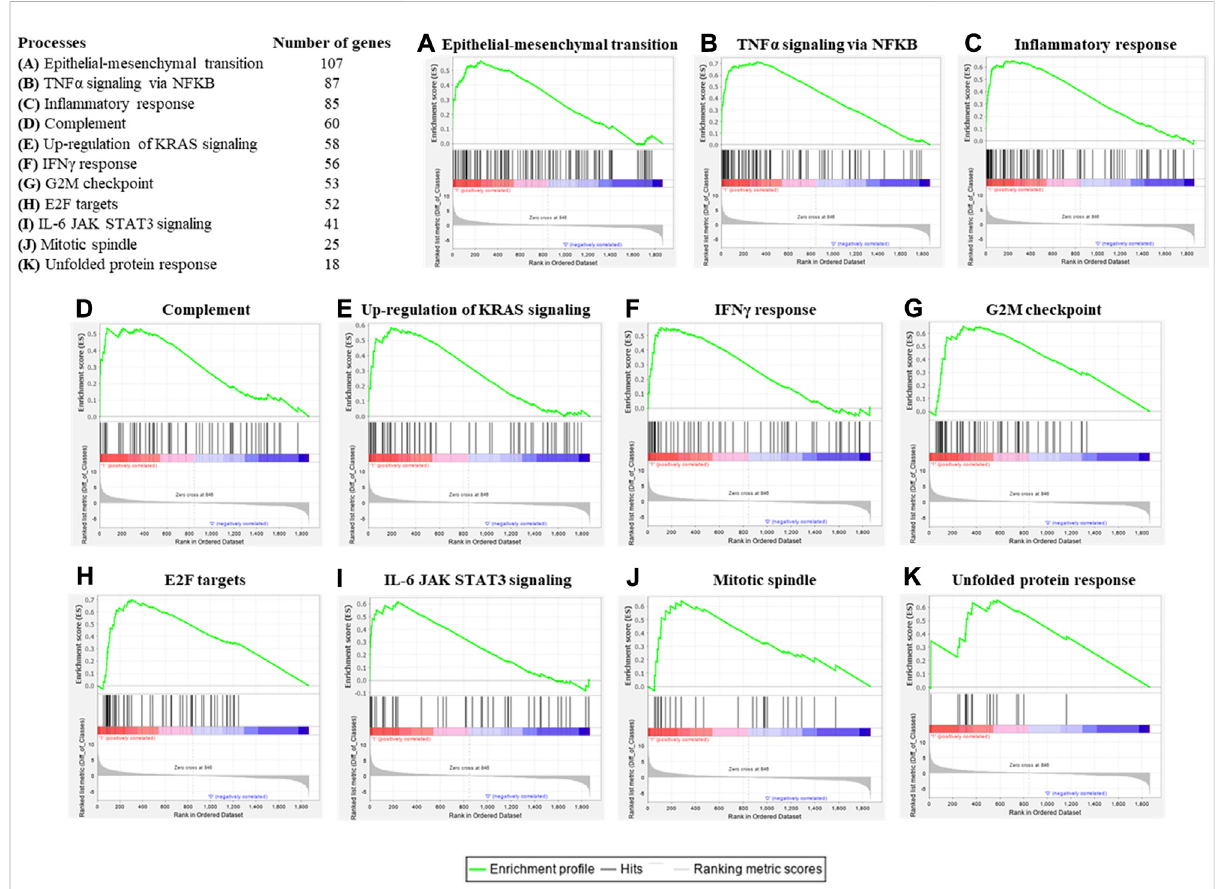
FIGURE 3 Enrichment plots of signi fi cant gene sets belonging to the (H) collection by GSEA. Table shows the hallmark processes identi fi ed by GSEA as signi fi cantlyenriched( p valueandqvalue < 0.05)andthenumberofgenesbelongingtoeachgenesetandthatwasdetectablealsointhegenearray. Enrichmentplotsforepithelial-mesenchymaltransition (A) ,TNF α signaling via NF-KB (B) ,in fl ammatoryresponse (C) ,complement (D) ,up-regulation of KRAS signaling (E) , IFN γ response (F) , G2M checkpoint (G) , E2F targets (H) , IL-6 JAK STAT3 signaling (I) , mitotic spindle (J) and unfolded protein response (K) were shown. An enrichment plot shows the gene set name (top), the running enrichment score (green curve), the positions of the gene set hits on the rank ordered list in GSEA (black bars), and the rank ordered list according to the signal-to-noise metric (bottom). Red indicates the up-regulation, whereas blue indicates the down-regulation of genes in the gene expression pro fi le of ASCs after IL-1 β priming.